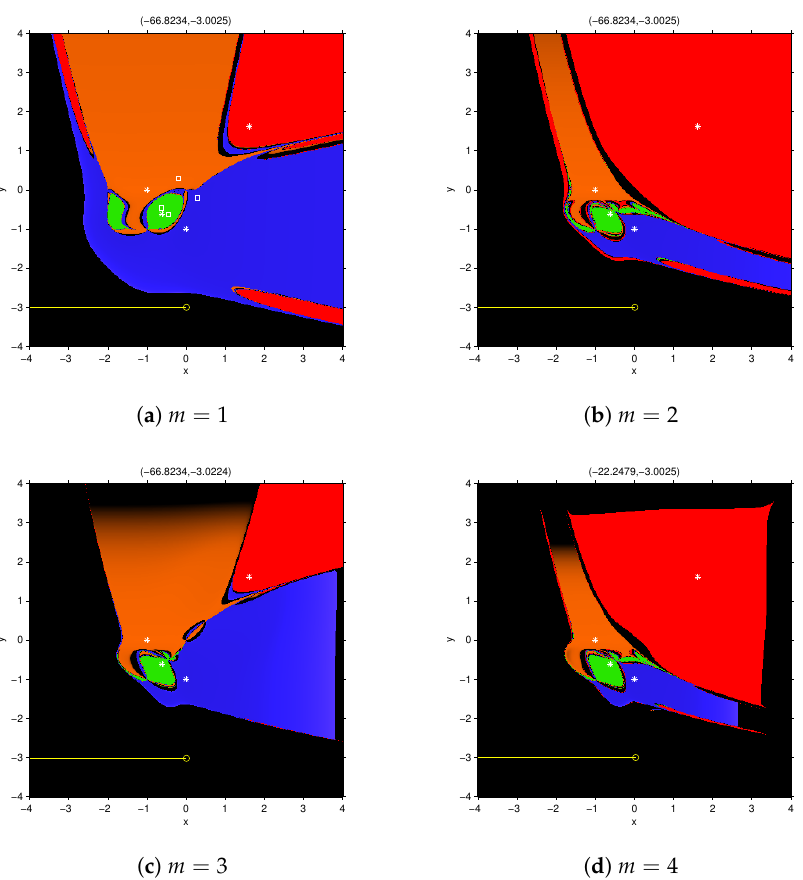
Figure 8. Dynamical plane for FMN m method, m = 1,2,3,4 on p ( x ) . Green, orange, red and blue areas are the basins of attraction of the roots of q ( x ) (marked as white stars); black area denotes divergence and white squares are free critical